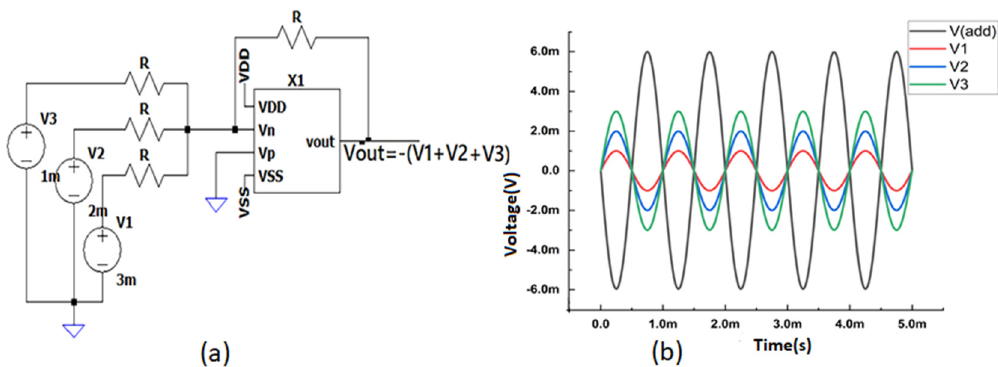
Figure 7. ( a ) Adder circuit. ( b ) Simulation output.